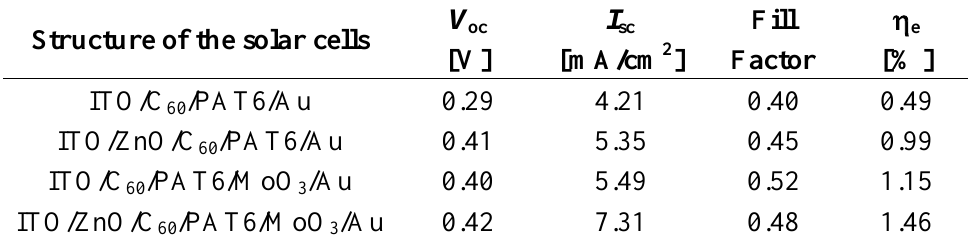
Table 1. Performance parameters in current-voltage characteristics of the solar cells with no buffer layer, ZnO buffer layer (50 nm), MoO buffer layers (50 nm and 6 nm, respectively) under solar-illuminated conditions.